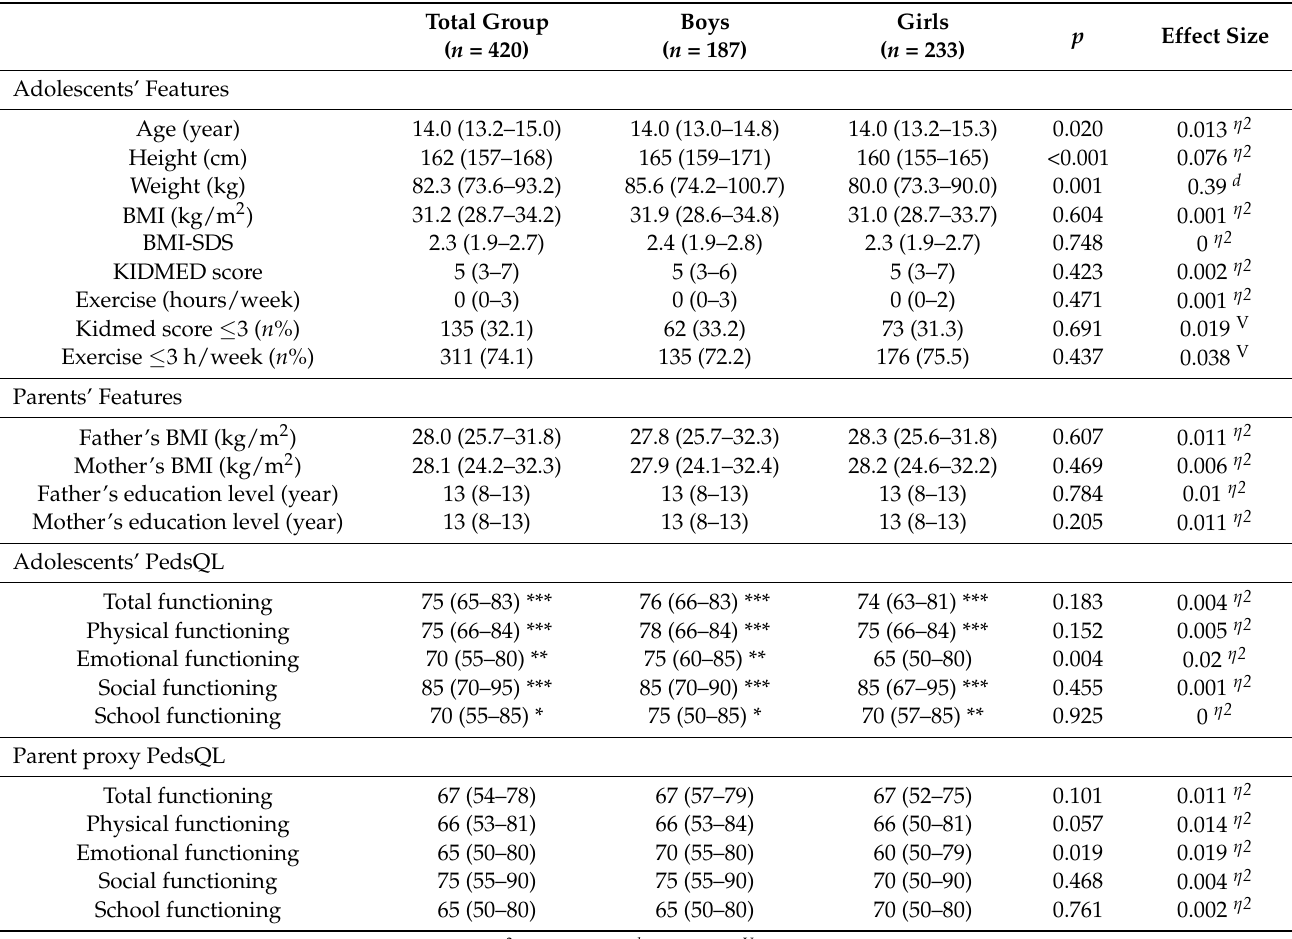
Table 1. Participants’ demographic and anthropometric features, lifestyle habits, parental characteristics, and PedsQL scores of adolescents and parents of the total sample and stratified by